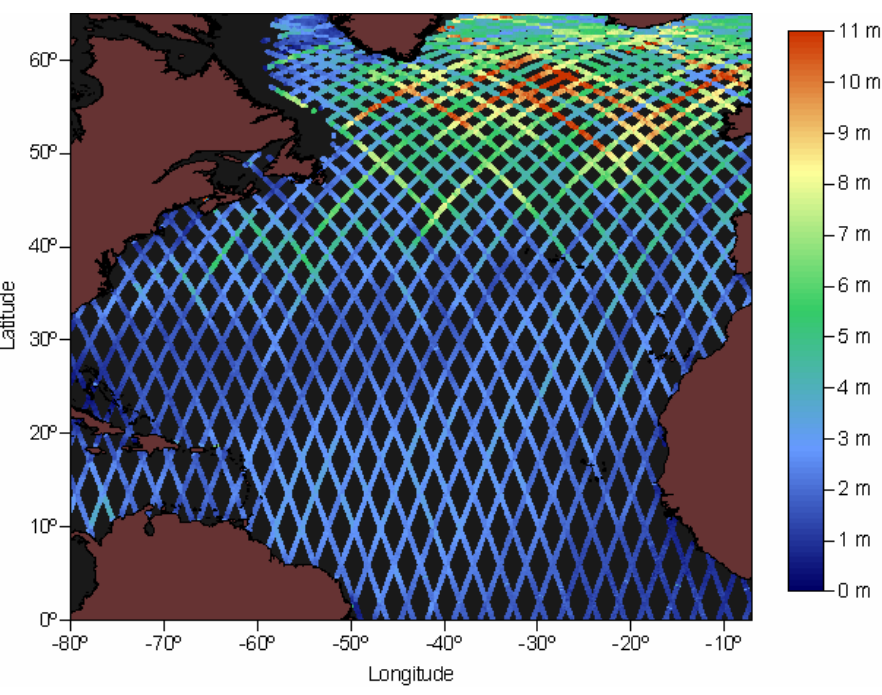
Figure 15a. Significant wave height for cycle 273 (February 2000).